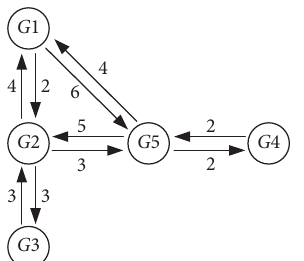
Figure 2: The topology graph of the generator model.